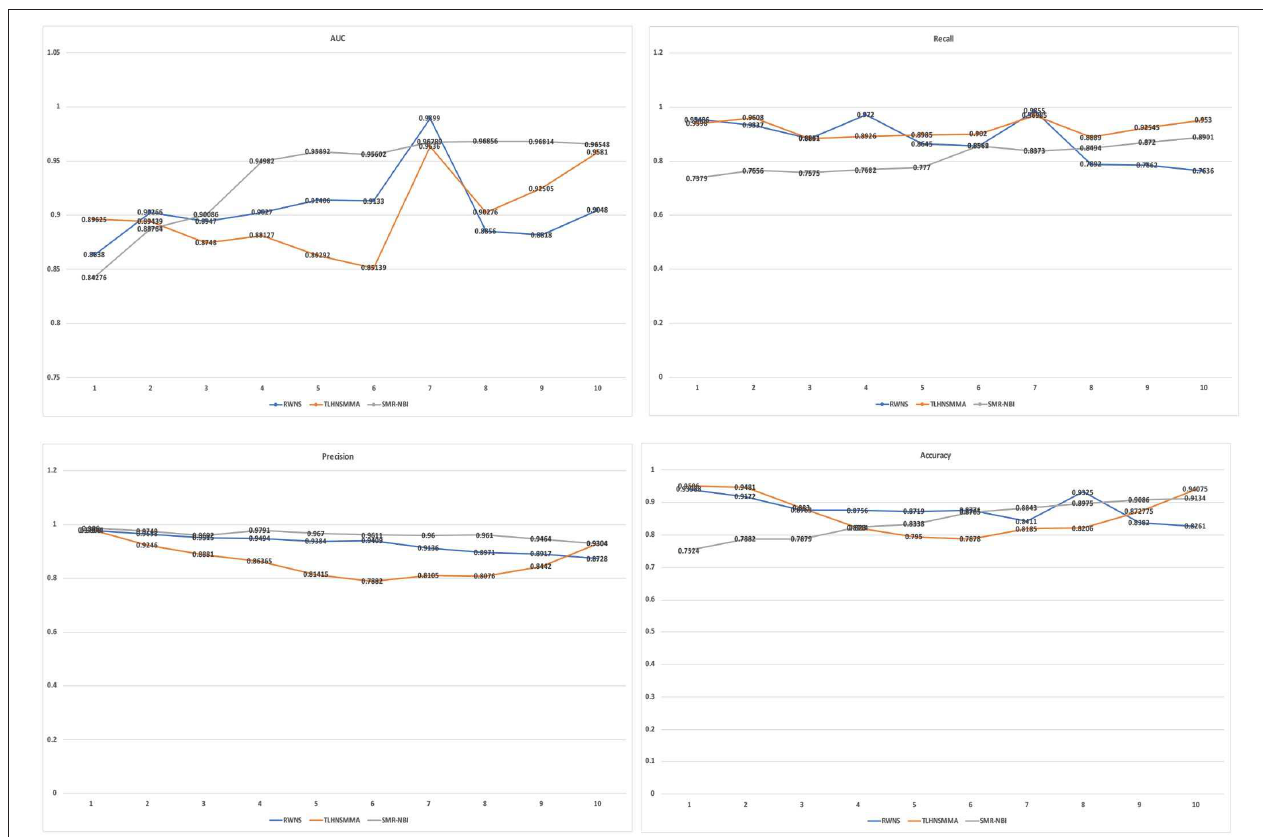
FIGURE 6 | The performance comparison of RWNS, TLHNSMMA, and SMiR-NBI under 5-fold cross validation on SM2miR2.